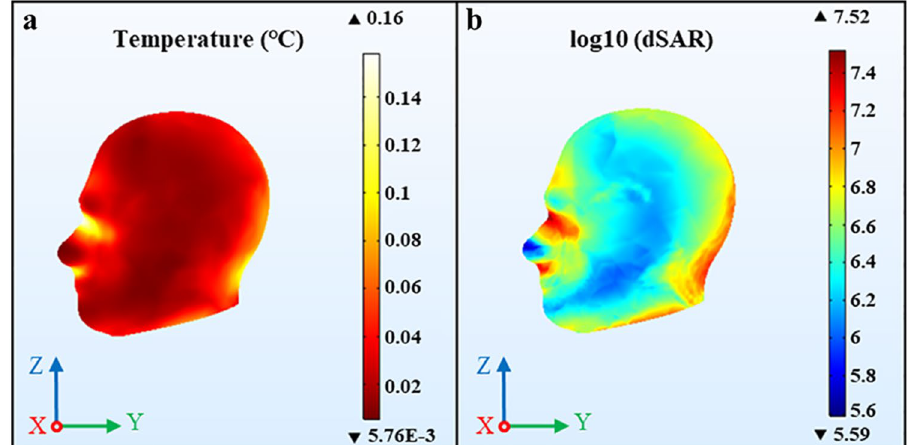
Figure 3. The temperature distribution and SAR values distribution of the head with benchmark parameters. ( a ) The temperature distribution, ( b ) the SAR distribution. We used COMSOL Multiphysics software, version 5.4 (https:// www. comsol. com/ comsol- multi physi cs) for simulation